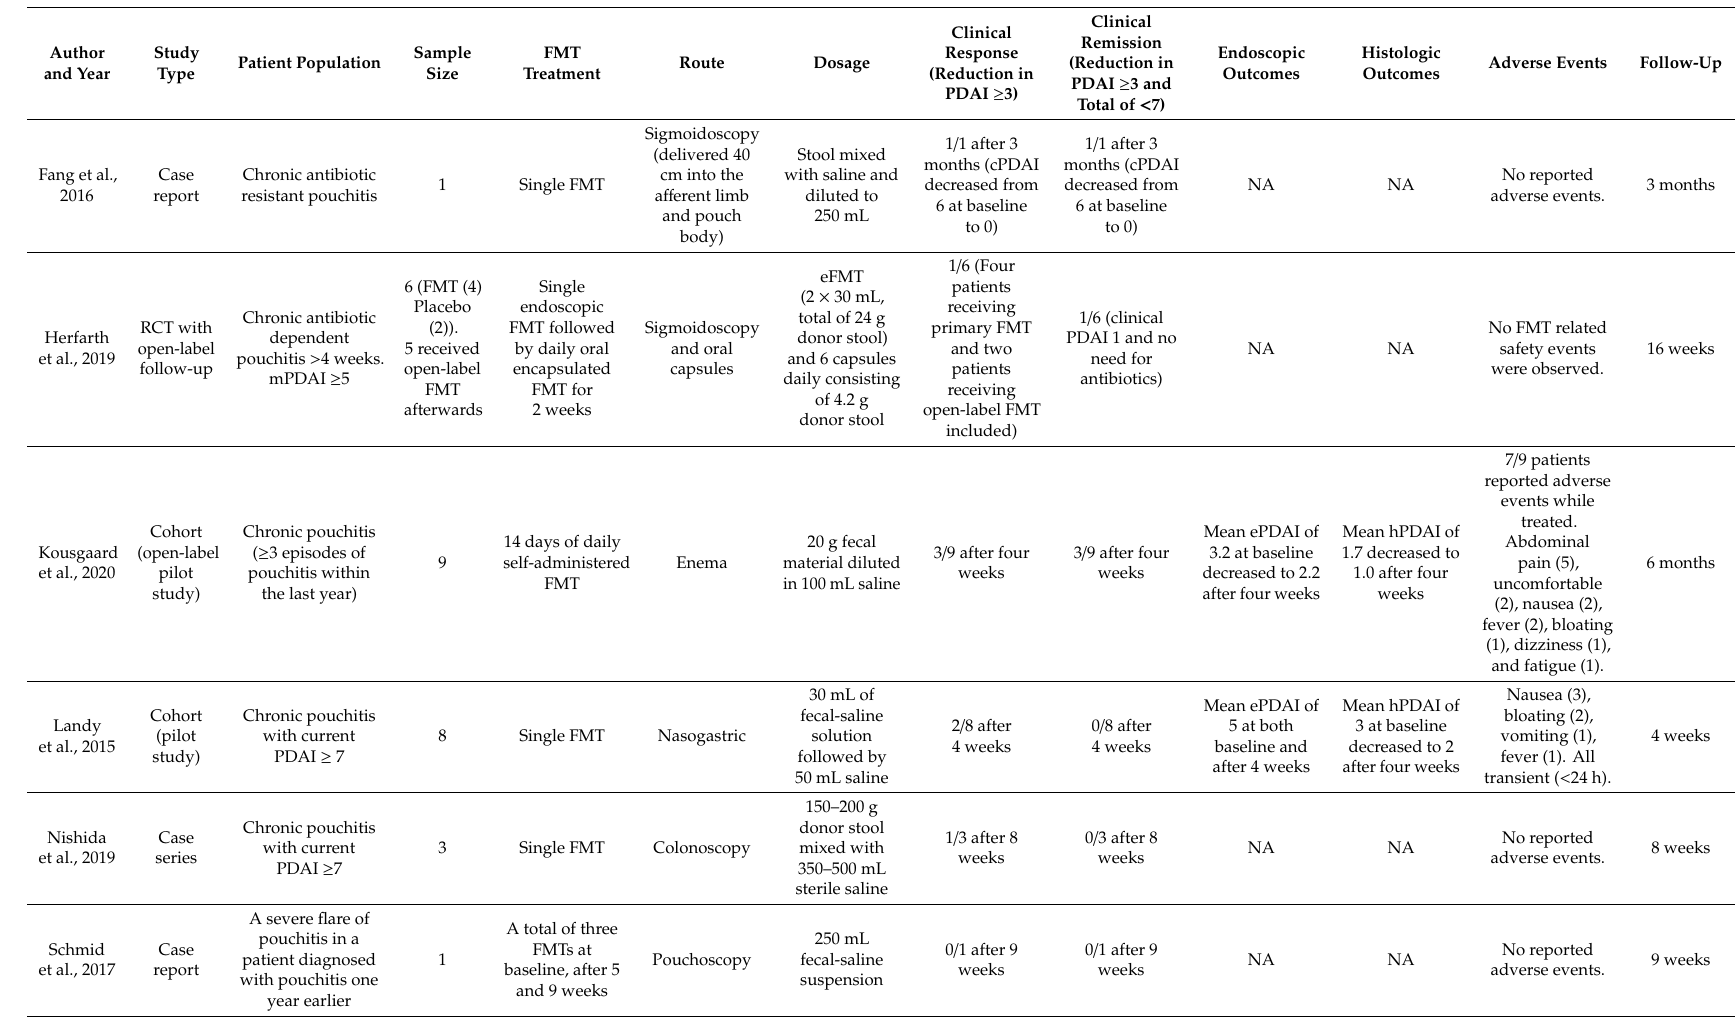
Table 2. Clinical e ff ects of FMT treatment to patients with chronic